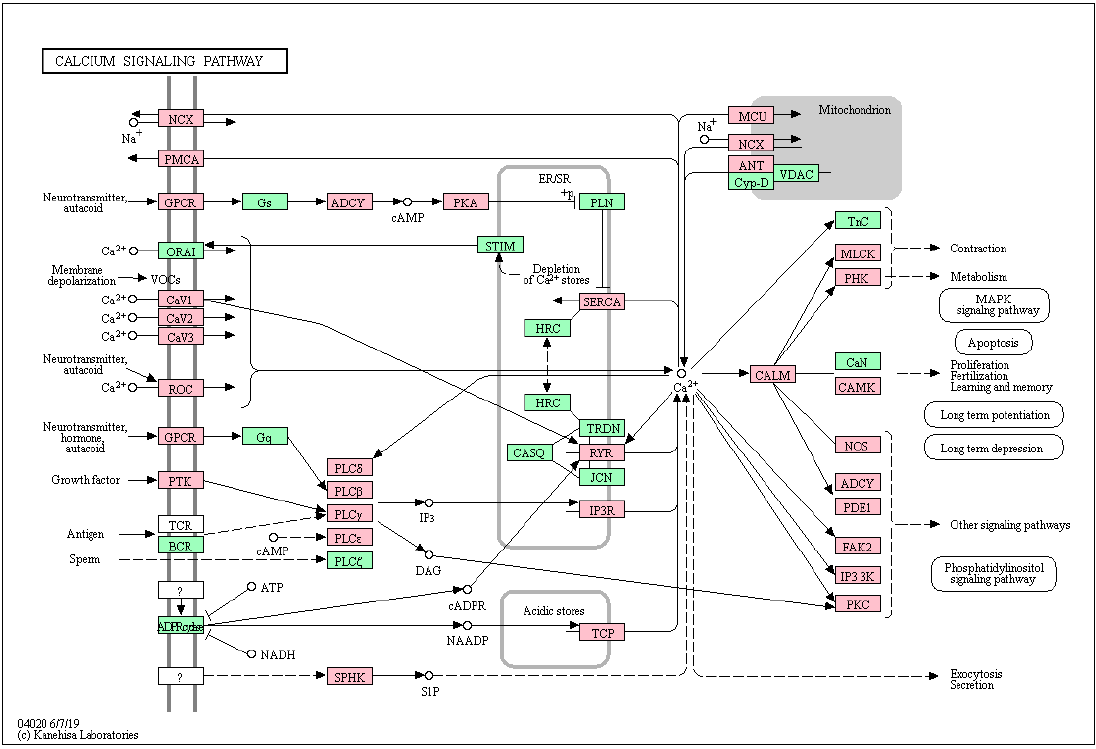
Figure 1. The KEGG calcium signaling pathway. Genes of the calcium pathway that carry a mutation in at least one case of uveal melanoma are indicated in red.